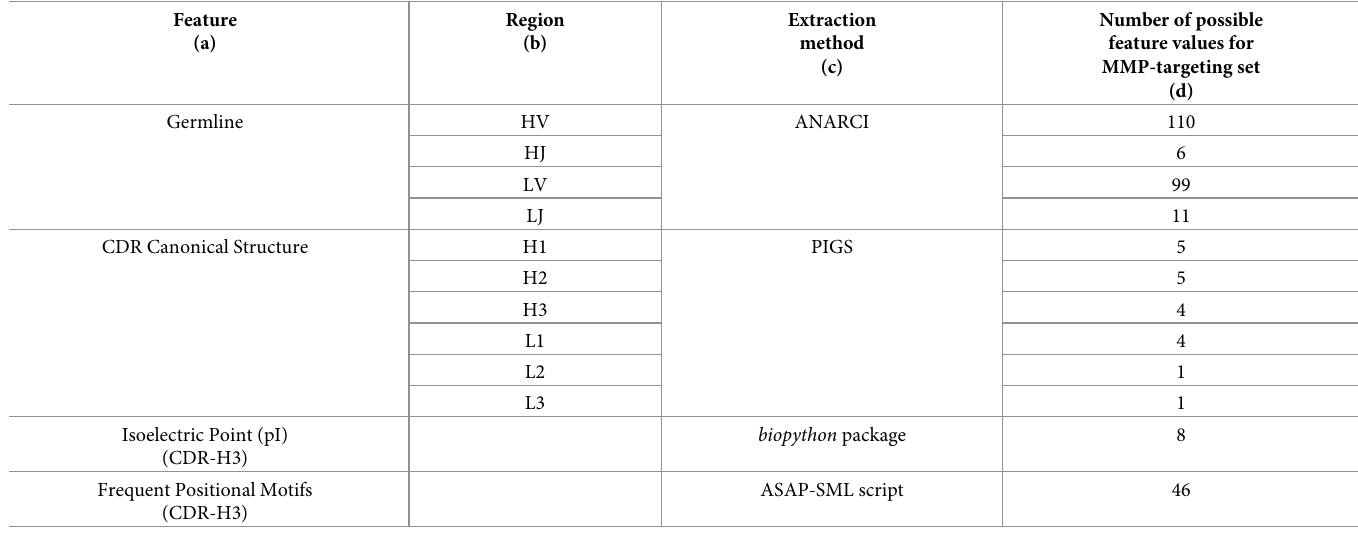
Table 1. Extracted features. Listing of (a) features in the fingerprint vector, (b) regions within antibody that exhibit the feature, (c) software extraction method, and (d) number of possible feature values for the MMP-targeting set test case. Feature Region (a)